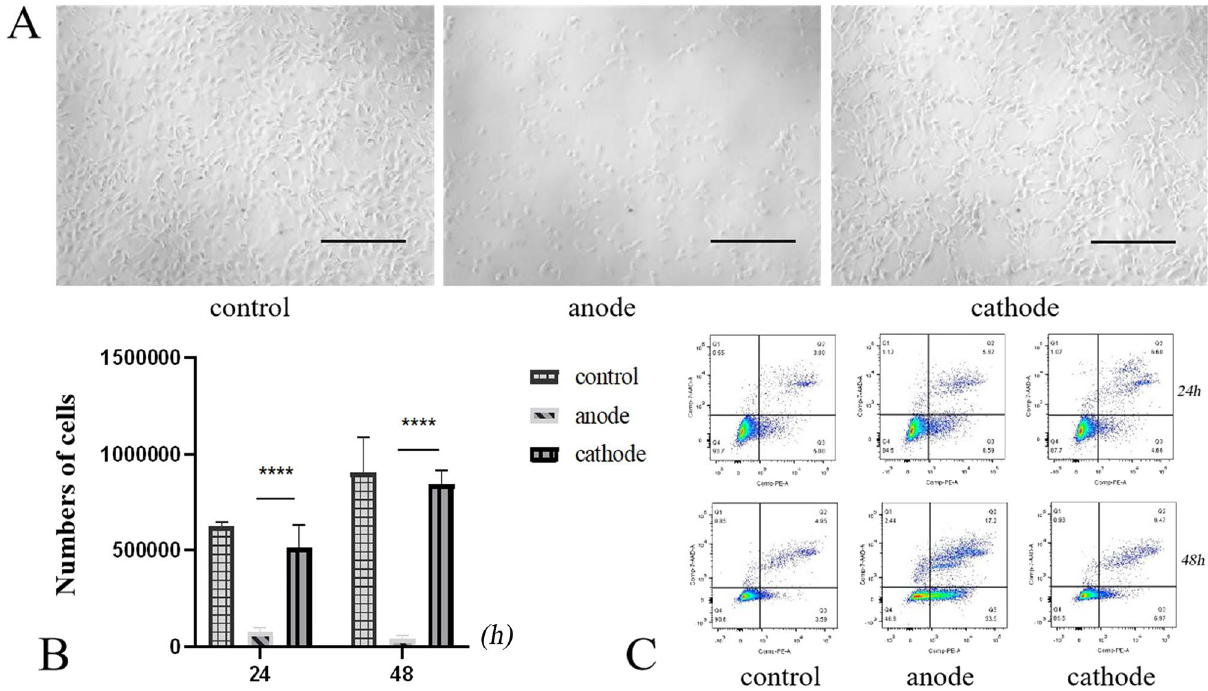
Figure 3. ( A ) Morphological observation of MC3T3-E1 cells under an optical microscope after two days of electrical stimulation (×100), scale bars 200 µm. ( B ) Cell counts in the positive electrode, negative electrode, and control groups after DC stimulation for 24 and 48 h. ( C ) Apoptosis of cells near the positive and negative electrodes in the control and electrical stimulation groups at 24 and 48